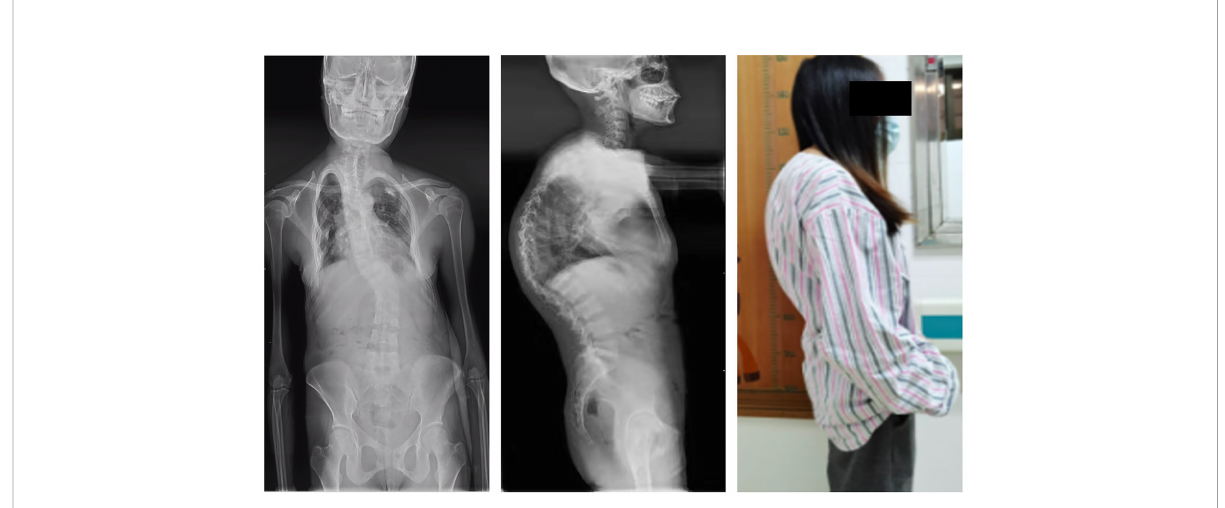
FIGURE 6 Whole-spine splicing X-ray anterior and lateral views. At the onset of the disease, the adefovir patient obvious severe scoliosis: rightward bending